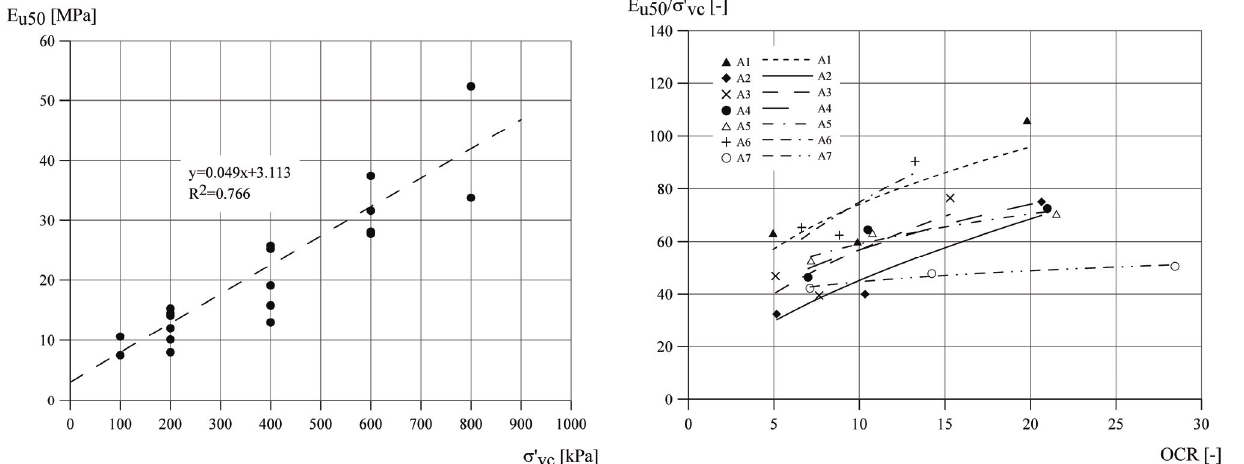
Fig. 5. The normalized undrained modulus E u 50 versus OCR  vc